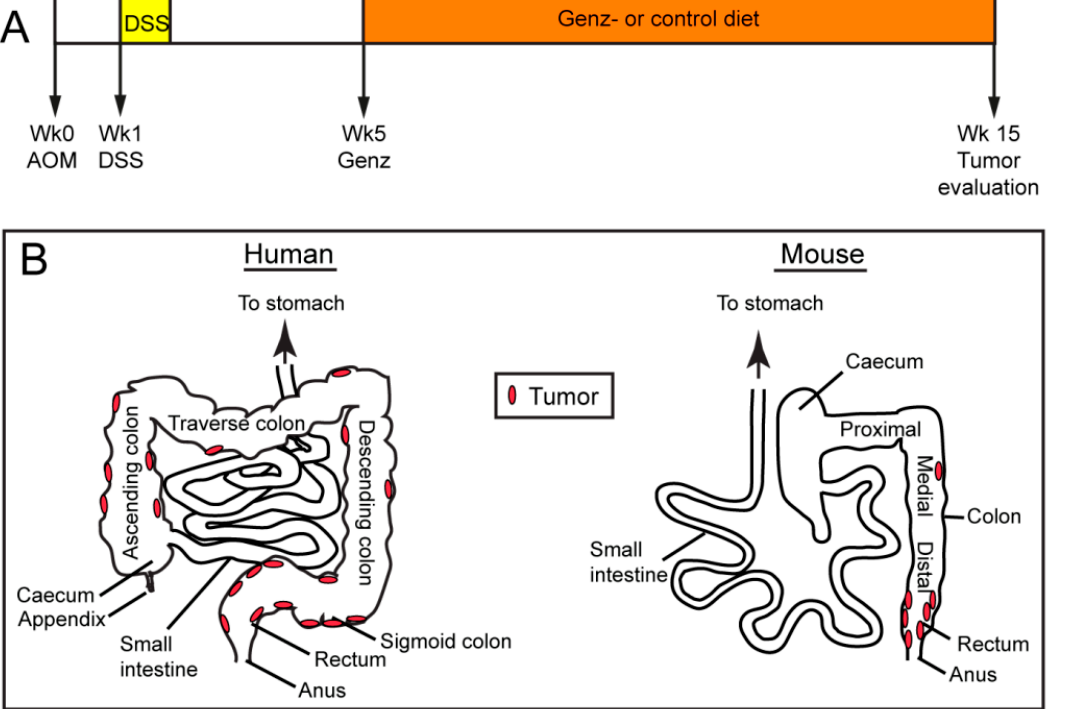
Figure 7. Genz treatment lowered the incidence of experimental CRC in vivo. ( A ) Scheme of the treatment course. CRC was induced in C57Bl6 mice with azoxymethane (AOM) at the age of 8 weeks, followed by a tumor promoting 5-day cycle of dextrane sulfate (DSS) applied by the drinking water starting one week after the AOM-treatment. Mice, n = 24, received chow diet until five weeks after tumor induction. Then one cohort of animals, n = 10, received 0.225% Genz in the food. All animals were sacrificed 15 weeks after tumor induction according to the termination criteria from the animal application. ( B ) Scheme of the human and murine intes- tinal tract. Colorectal tumors in humans develop preferentially in the areas of the sigmoid colon and the rectum but also in other areas of the large intestine. In this mouse model, we observed tumors predominantly restricted to the rectal area of the colon with a critical load at fifteen weeks after tumor induction. ( C ) Treatment of mice with Genz resulted in a markedly lower number of colo- rectal tumors in the distal part of the colon. ( D ) The size of tumors detected in the colons of Genz-treated mice was also notably smaller as compared to chow fed mice; each data point represents the mean size of all tumors detected in one mouse; significances are *, p ≤ 0.05; **, p < 0.01.